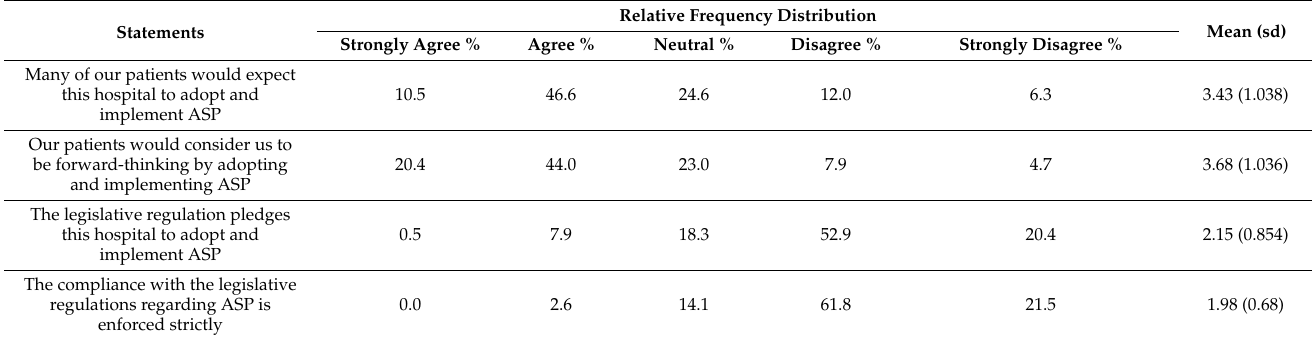
Table 6. Perceived patients’ demands and legislative pressures to adopt